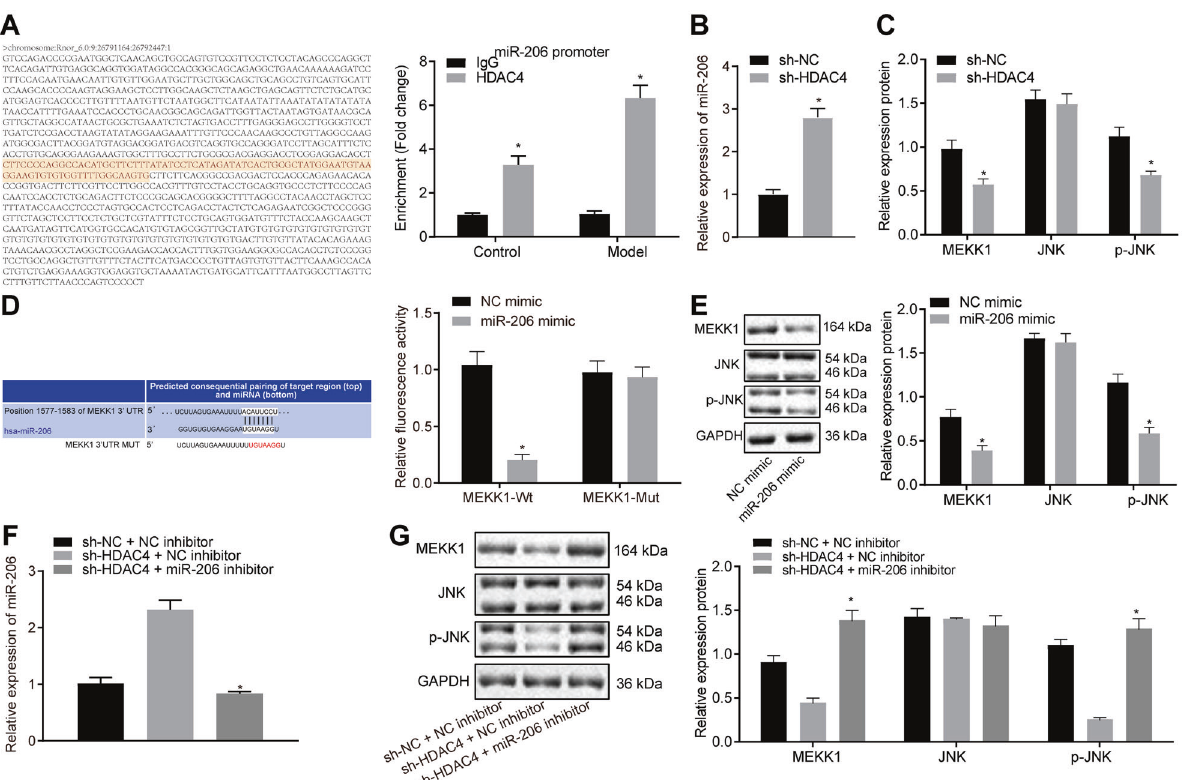
Fig. 4 Silencing of HDAC4 elevates the expression of miR-206 and further inhibits the activation of the MEKK1/JNK pathway in cardiomyocytes from IRI rats. A The binding of HDAC4 to the promoter region of miR-206 identi fi ed by ChIP assay. B Expression of miR-206 in sh-HDAC4-treated cardiomyocytes determined by RT-qPCR. C Protein expression of MEKK1, JNK and p-JNK in sh-HDAC4-treated cardiomyocytes measured by western blot analysis, normalized to GAPDH. D The interaction between miR-206 and MEKK1 detected by dual luciferase reporter gene assay. E Protein expression of MEKK1 and JNK in miR-206 mimic-treated cardiomyocytes determined by western blot analysis, normalized to GAPDH. F Expression of miR-206 in cardiomyocytes transfected with sh-HDAC4 or sh-HDAC4 + miR-206 inhibitor measured by RT-qPCR. G The expression of MEKK1 and p-JNK in the cardiomyocytes transfected with sh-HDAC4 or sh-HDAC4 + miR-206 inhibitor measured by western blot analysis, normalized to GAPDH. * p < 0.05 vs. the cardiomyocytes transfected with sh-NC, NC mimic, NC inhibitor, or sh-HDAC4 + NC inhibitor. Data were measurement data and expressed as mean ± standard derivation. Comparisons between two groups were analyzed by the unpaired t- test, and comparisons among multiple groups were analyzed by one-way ANOVA, followed by Tukey ’ s host hoc test. The experiment was conducted three times